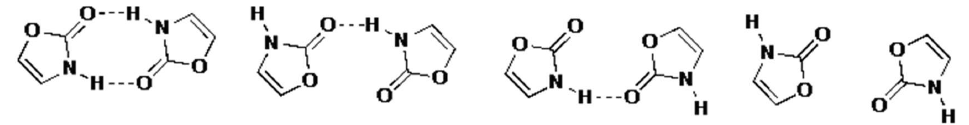
Figure 5. Different hydrogen bonding situations resulting from positional disorder in the crystal between ring O and